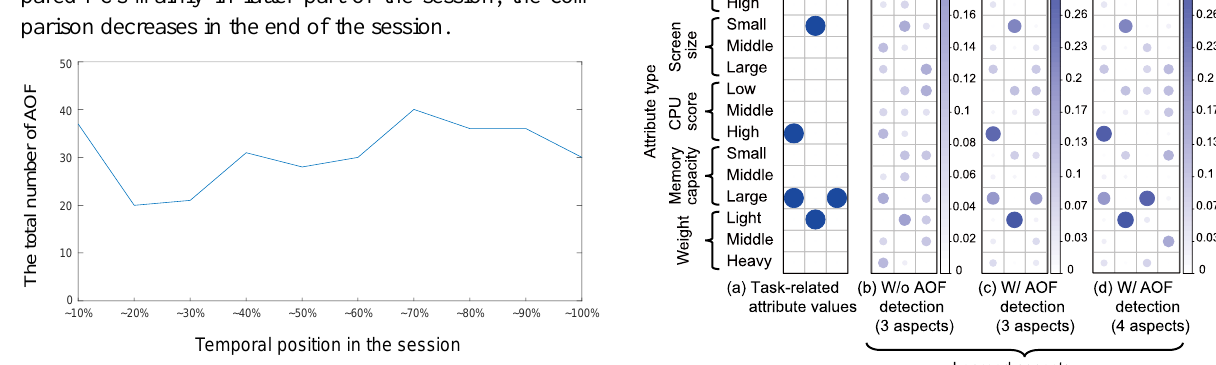
Figure 8. The total number of AOF detected in each temporal position in the session. Figure 9. Task-related attribute values and learned aspects